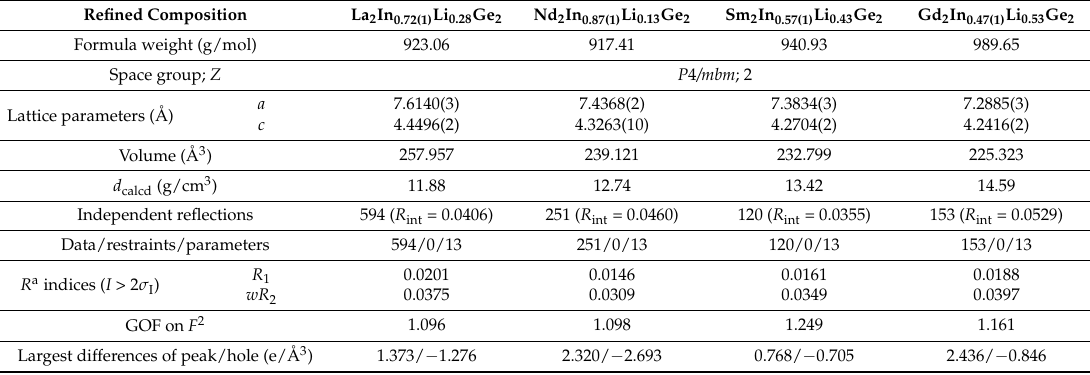
Table 1. SXRD data and structure refinement results for the RE 2 In 1 − x Li x Ge 2 ( RE = La, Nd, Sm, Gd; x =